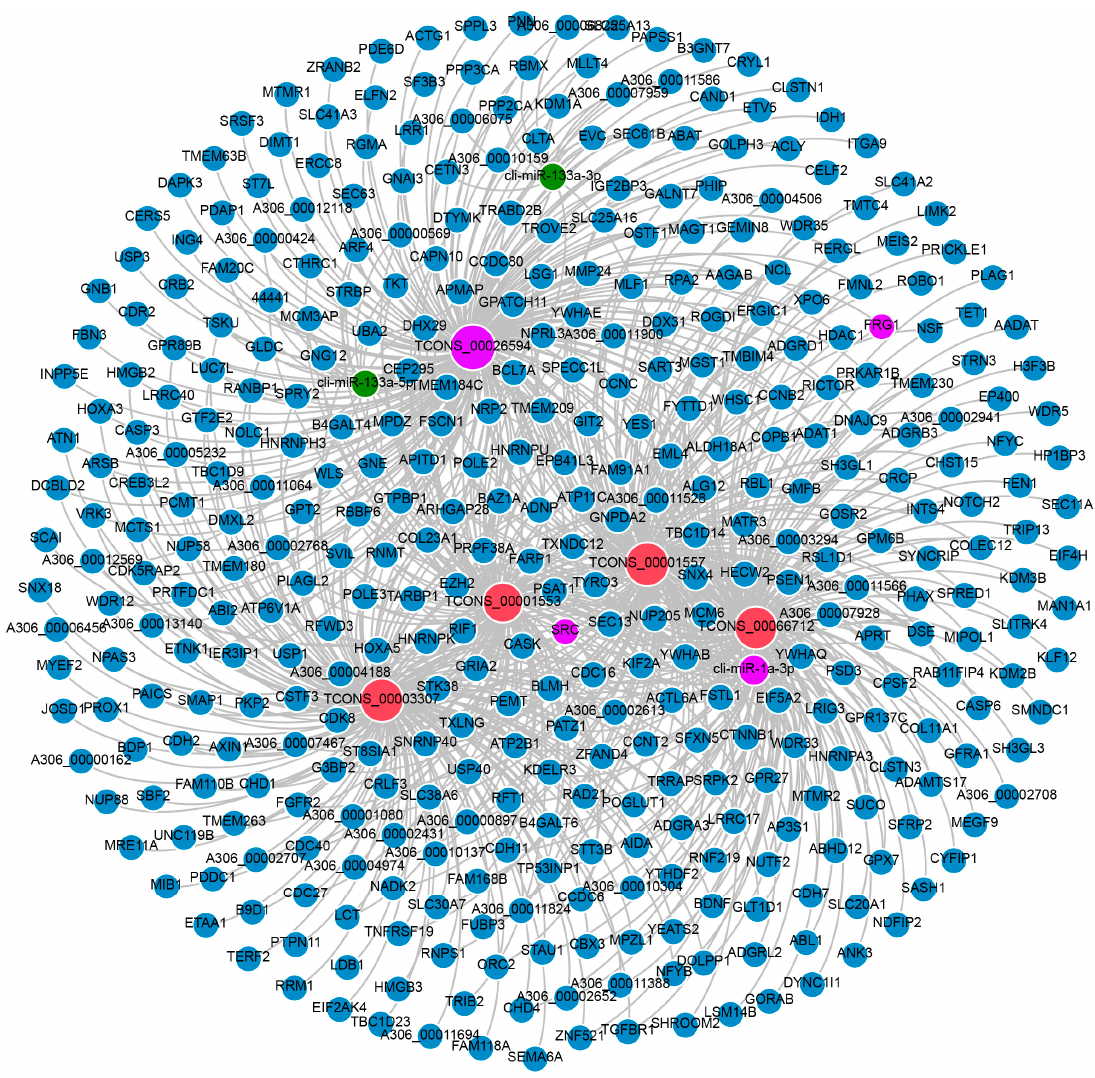
Figure 5. Visualization of the 136 crucial lncRNA–miRNA–mRNA interactions. Red, green, and blue nodes represent lncRNA, miRNA, and mRNA, respectively. Pink nodes represent the ceRNA interactions validated by dual-luciferase assay. The node size is proportional to the connectivity degree.